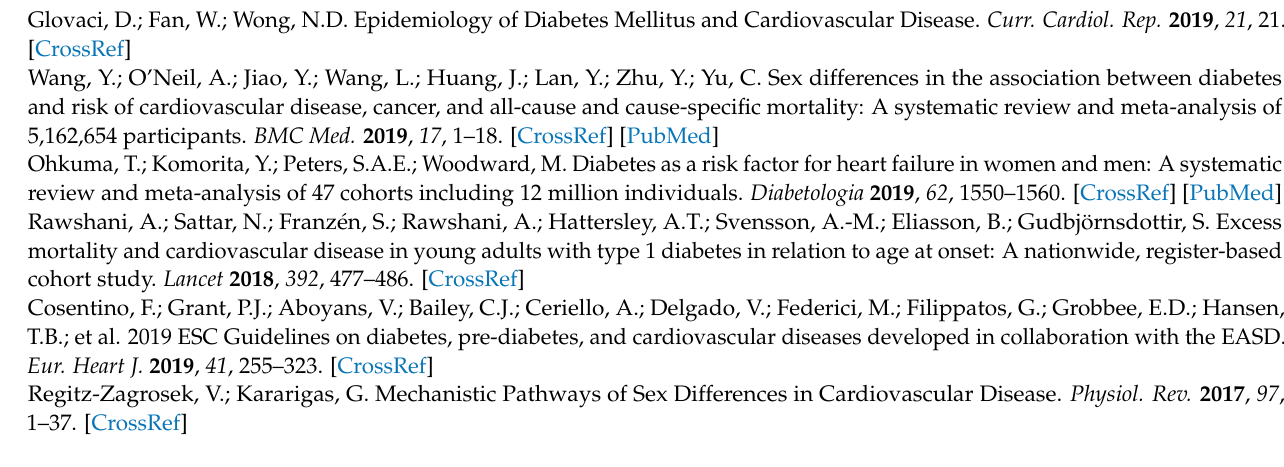
diovascular and thyroid parameters, Table S2: Correlation between IL-27 serum levels and selected cardiovascular and thyroid parameters, Table S3: Correlation between visfatin serum levels and selected cardiovascular and thyroid